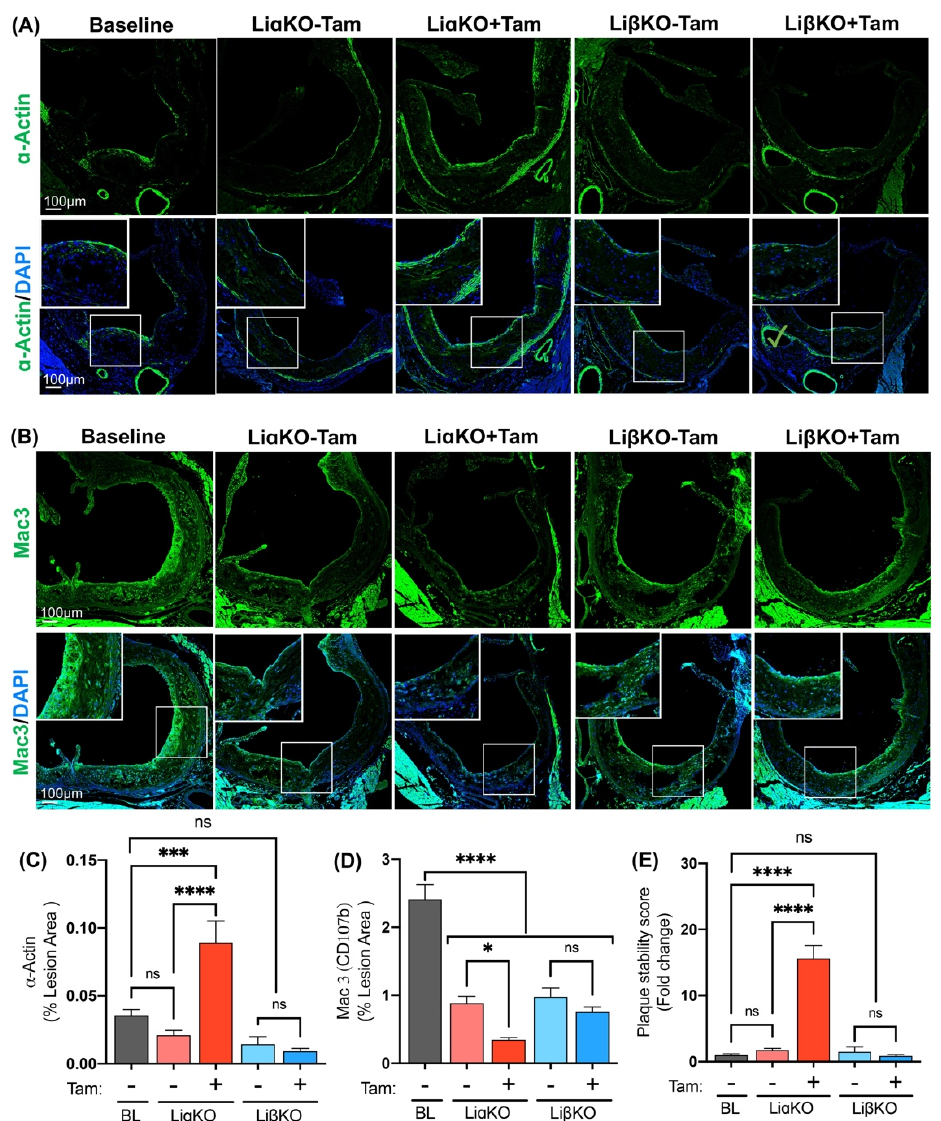
Figure 3. Macrophage-specific GSK3 α -deficiency promotes a phenotype associated with atheroscle- rotic plaque stability in female Ldlr − / − mice. Representative sections of aortic sinus immunostained with an antibody against ( A ) CD107b (Mac3, green) for macrophages and ( B ) α -actin (green) for smooth muscle cells. Quantification of ( C ) CD107b/Mac3 and ( D ) α -actin stained area normalized to the total lesion area. ( E ) Quantification of plaque stability score (SMC area/macrophage area). n = 9–13; mean ± SEM; * p < 0.05, *** p < 0.001, **** p < 0.0001 (one-way ANOVA). ns, not significant; Tam, tamoxifen; BL, baseline.